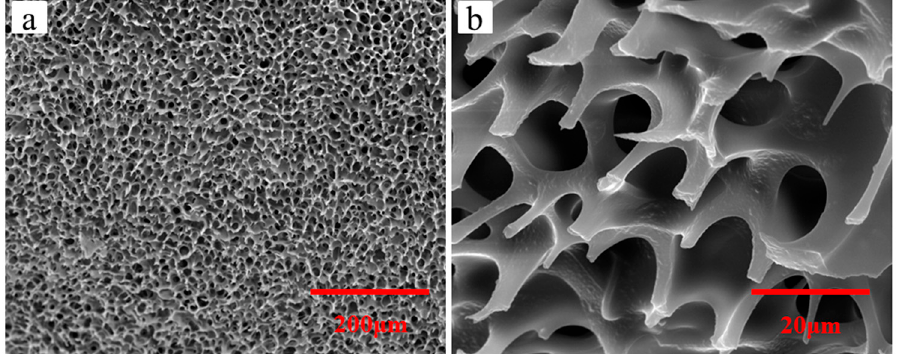
Figure 2. Micrograph of emulsion at ( a ) low- and ( b ) high-magnification.